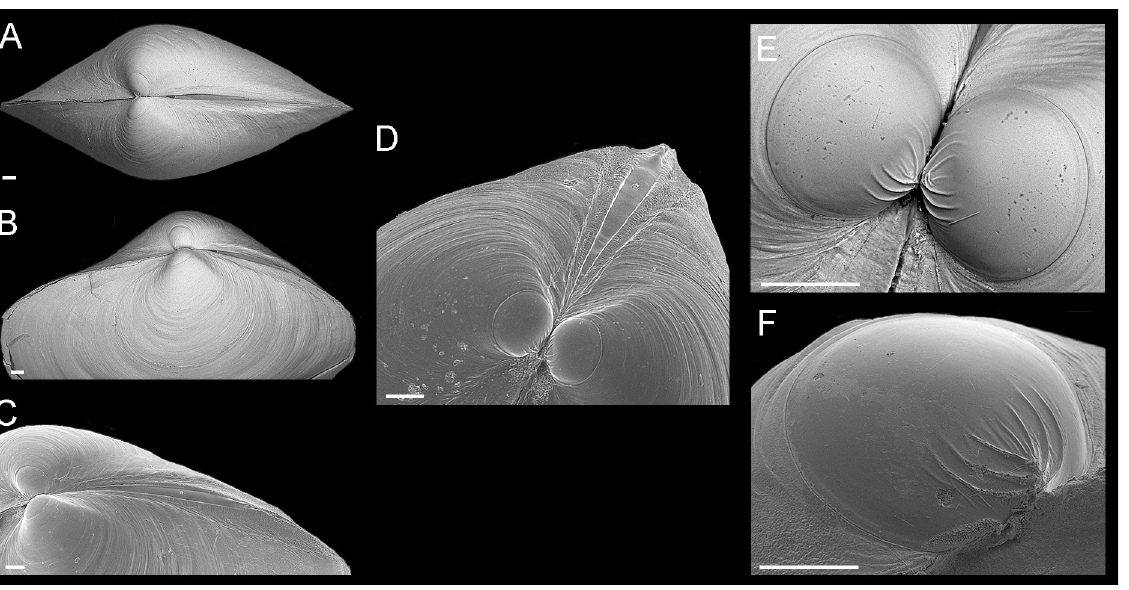
Fig. 15. Scanning electron micrographs of Thyasira kharkovensis sp. nov. A–B . Dorsal and oblique dorsal views of both valves (MIMB 43835). C–D . Escutcheon with auricle (MIMB 43835). E . Prodissoconchs. (MIMB 43835). F . Prodissoconch (MIMB 43826). Scale bars = 100